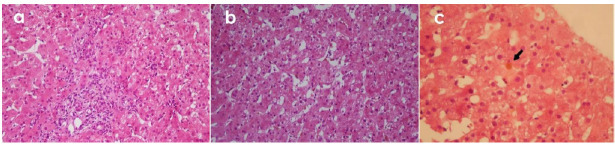
 a) Low power view of the liver portal tract and surrounding hepatocytes (The portal tract has slight lymphocytic
infiltration with occasional permeation of plates), b) Another portal tract with mild infiltration
of lymphocytes without invasion to limiting plates (Hepatocytes are unremarkable.), c) Higher view
of hepatocytes without lobular hepatitis (There is a focal area of cholestasis [black arrow] in the center; hematoxylin- eosin X400]).